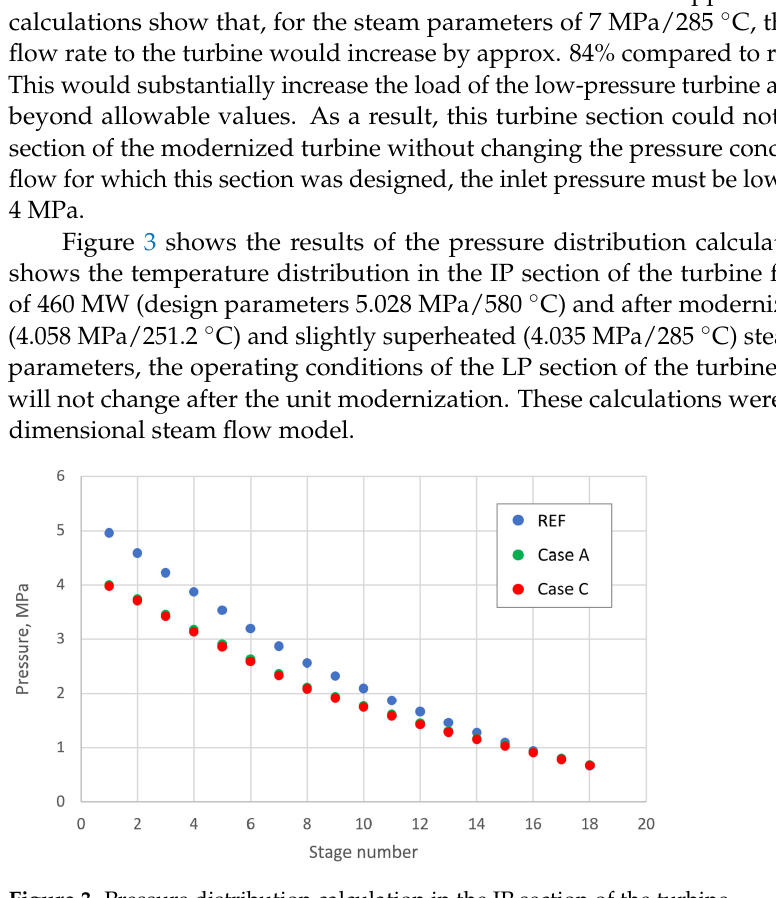
Figure 4. Temperature distribution calculation in the IP section of the turbine. The inlet pressure is thus much lower than the assumed 7 MPa, which results in a drop in the modernized power unit efficiency. Wet steam expansion in the turbine stages causes a reduction in the efficiency of the stages due to the steam’s moisture content. 2.2. Modelling of the Steam Cycle The answer to the question of whether it is possible to use the existing IP section as the new HP section of the repowered unit must be found through a more detailed analysis based on balance calculations of the steam cycle. A model of the cycle was developed for this purpose to provide a solution in the form of steam and water parameters and the mass flow rate values at the model calculation points. A diagram of the cycle is presented in Figure 5.